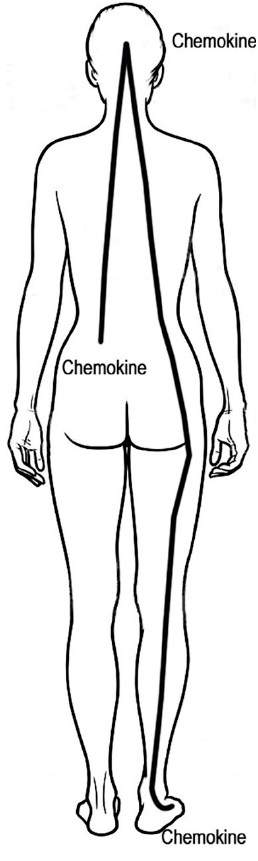
Figure 1. Proposed pain chemokine cycle from the skin to the brain and returning to the skin. The initial pain causes chemokine release in the skin, such as the lower back, which attracts monocytes, neutrophils and other inflammatory cells to the skin. Chemokines increase pain by lowering the action potential threshold of sensory neurons. Chemokines induce prostaglandin and IL-17 release in the skin, both of which increase chemokine release. Skin sensory neurons may stimulate the release of chemokines in the brain. Brain chemokines may modulate descending and peripheral neurons, resulting in chemokine release in the skin at the site of initial pain and other sites, such as the feet. This suggests that treatment of the feet may decrease chemokine production in the back, brain and other sites. There are many other macrophage- and neutrophil-derived cytokines involved in pain and inflammation such as tumor necrosis factor, IL-1 β , IL-3, IL-5 and IL-6 [18]. These cytokines may increase prostaglandin, norepinephrine and leukotriene B 4 release in the skin, which enhances and prolongs pain [9,10]. Leukotrienes activate TRP channels to cause and prolong pain [19].